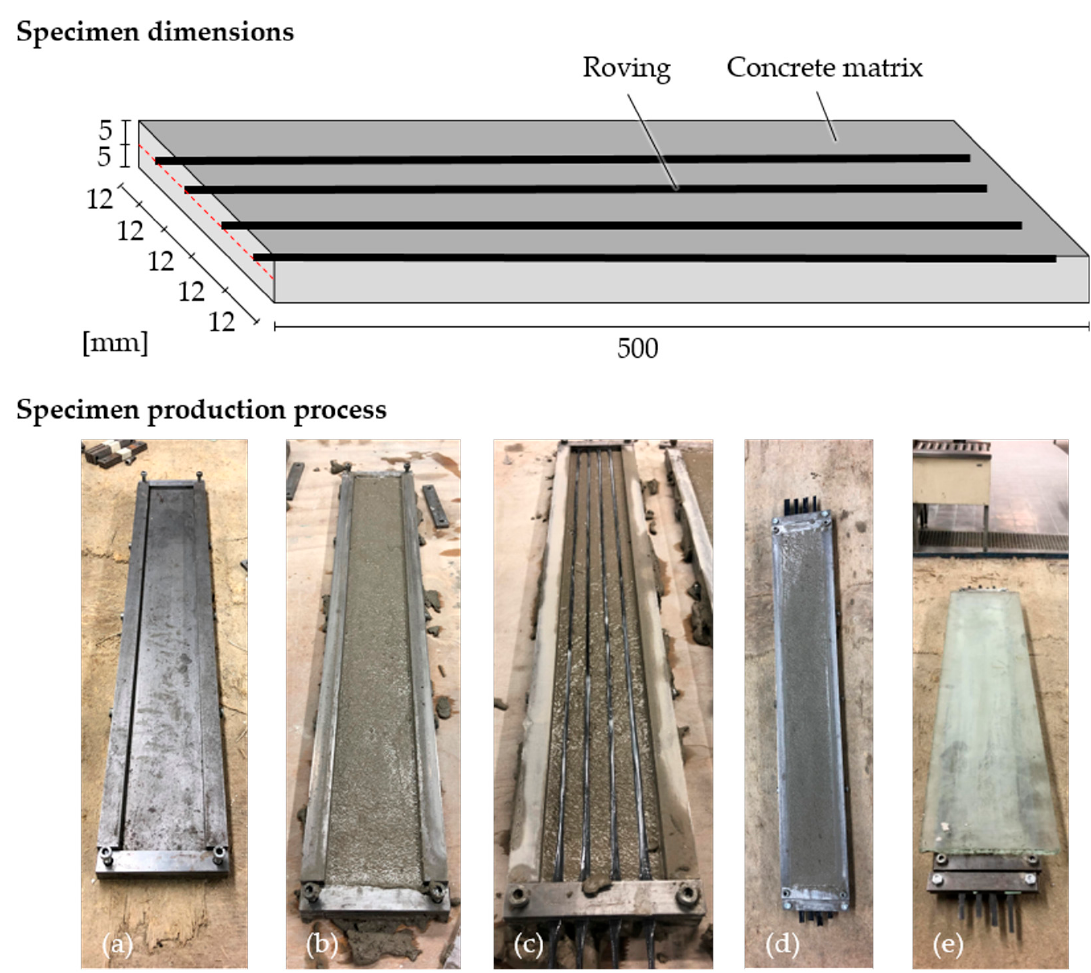
Figure 4. Representation of the tensile test specimens used in this work and their production process. Top: specimen dimensions; Bottom: production process: ( a ) clean mold; ( b ) first concrete layer; ( c ) placement of rovings; ( d ) second concrete layer; ( e ) placement of glass plate on top to ensure a smooth surface for clamping.